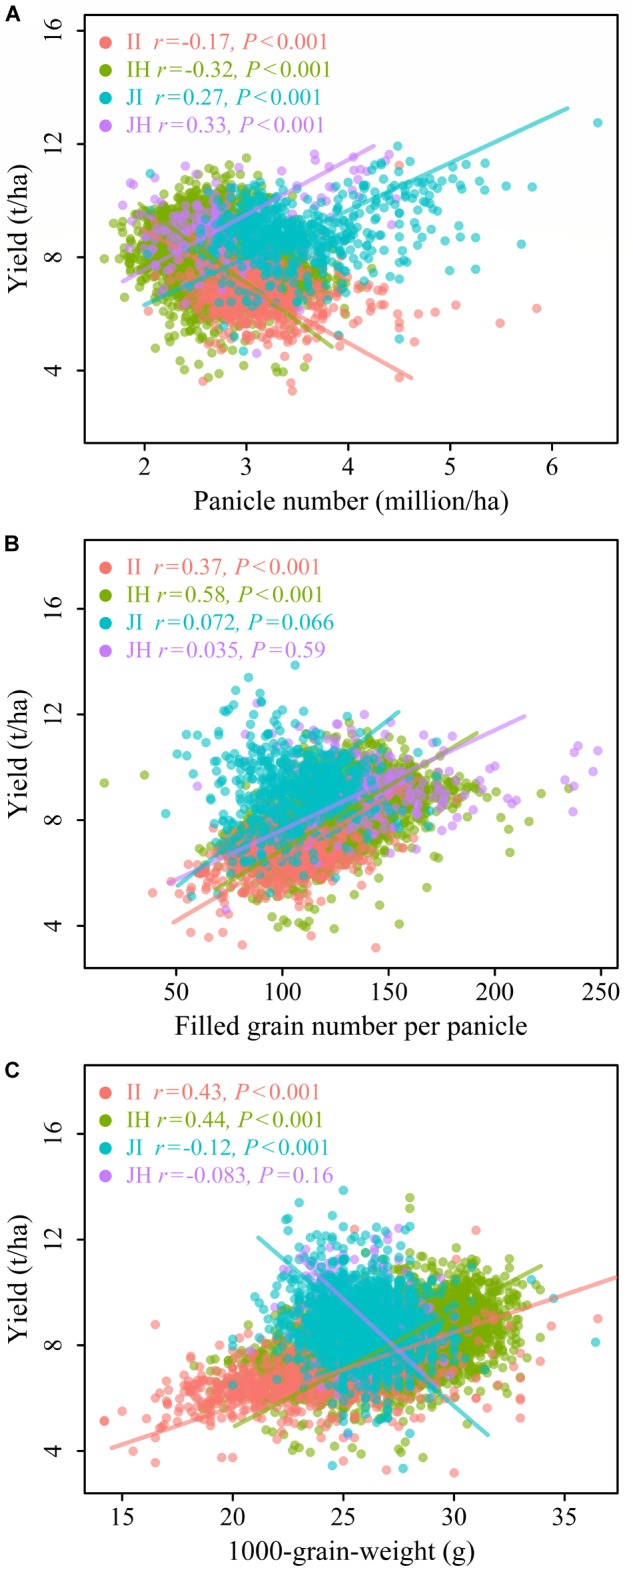
Relationships between grain yield and (A) panicle number per unit area, (B) filled grain number per panicle, and (C) 1,000-grain-weight for four rice ecotypes. The four ecotypes are: indica inbred (II), and indica hybrid (IH), japonica inbred (JI), and japonica hybrid (JH). Different rice ecotypes are represented with different colors. Colored lines present regression plots of different rice ecotypes. The details of these relations using reduced major axis (RMA) regressions are presented in Table 1. Pearson correlation coefficients (r) and their significance level (P) are shown.